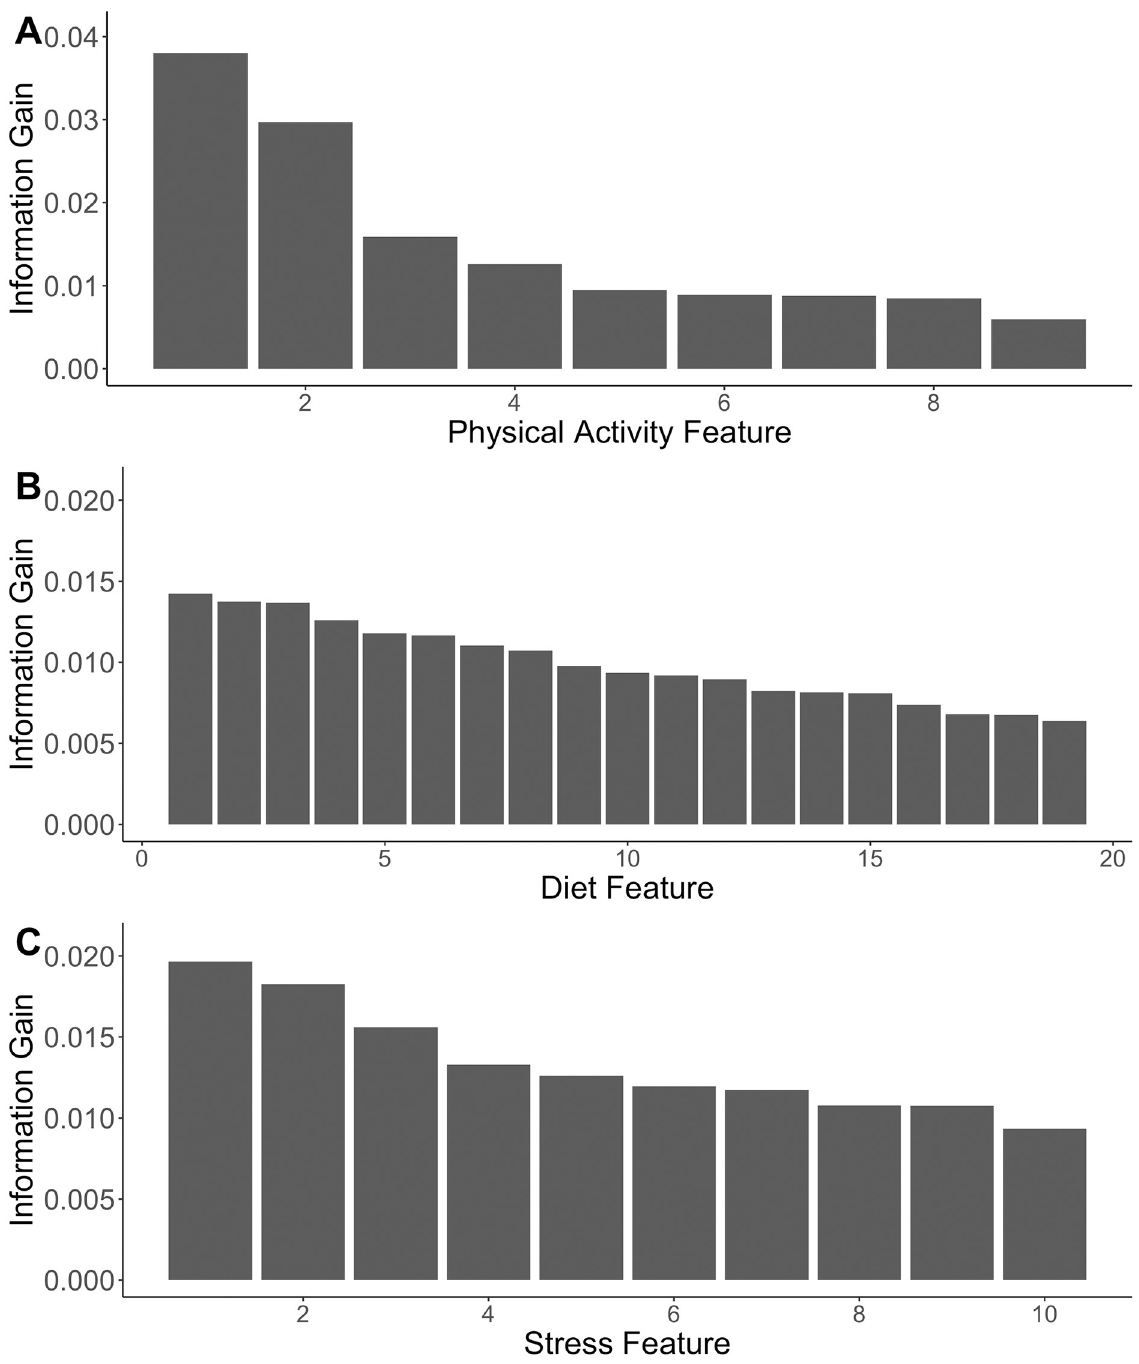
Fig 3. Features, ranked by amount of information gain they contribute. Classification models predicting A) stress class from physical activity; B) stress class from diet; and C) amount of sleep from perceived stress.